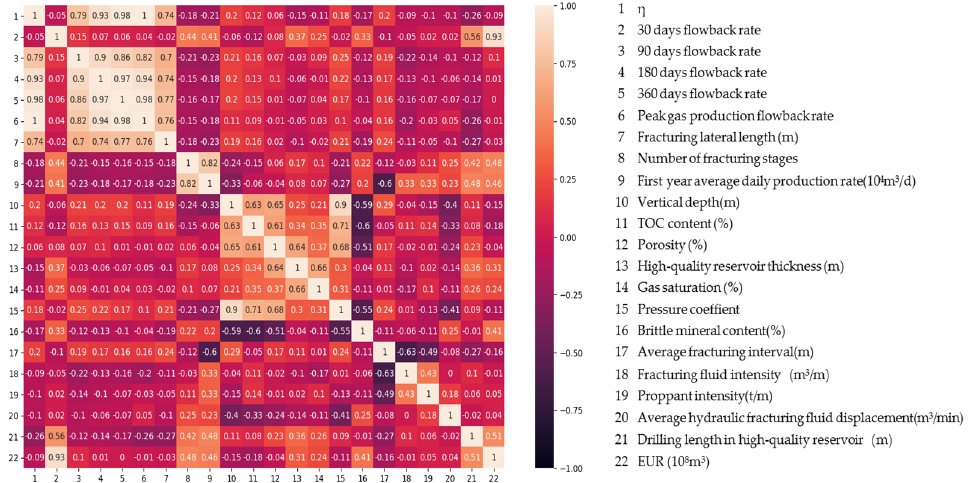
Figure 7. Hot map of correlations between η and static